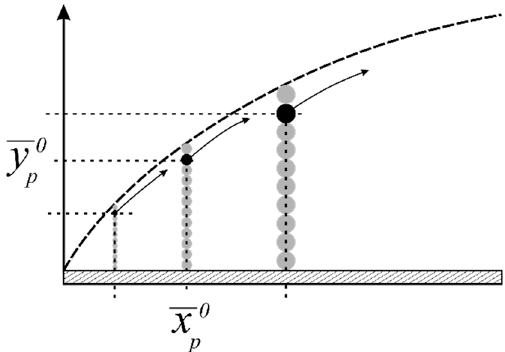
Figure 3. Idea about the choice of the initial conditions for the trajectory calculations.